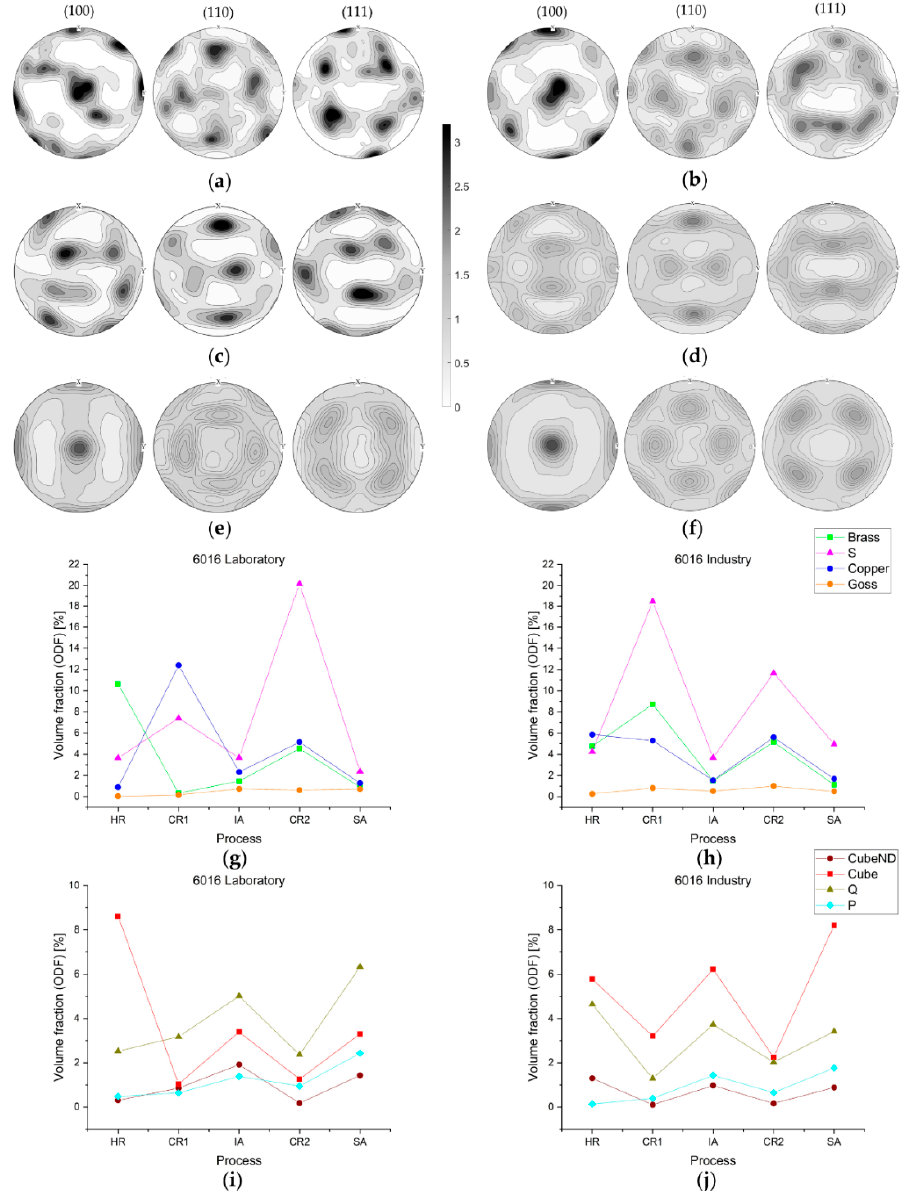
Figure 7. Evolution of texture components within sheet processing for EN AW-6016; (001), (110), and (111) pole figures based on ODF data for ( a ) HR laboratory, ( b ) HR industry, ( c ) CR2 laboratory, ( d ) CR2 industry, ( e ) SA laboratory, and ( f ) SA industry; diagrams ( g – j ) show the evolution of specific texture components over the entire processing route.